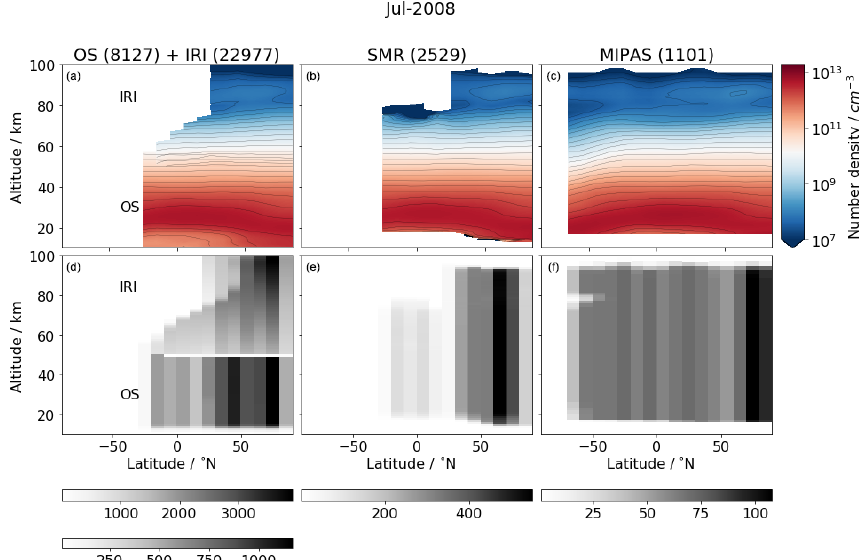
Figure 13. Zonally averaged daytime ozone number density observed in July 2008, with 10 ◦ latitude bins. The first column contains data from two instruments, with OS below 60km and IRI above 50km. The second and third columns correspond to SMR and MIPAS, respectively. The numbers in brackets indicated in the titles are the total number of profiles that are available within the month under consideration. The lower row corresponds to 2D histograms showing the number of samples that are accounted for the zonal average bins. Note that the greyscales of 2D histograms are different in the bottom row. The upper grey scale of the 2D histogram in (a) corresponds to IRI ( > 50km) and in (d) corresponds to OS ( <